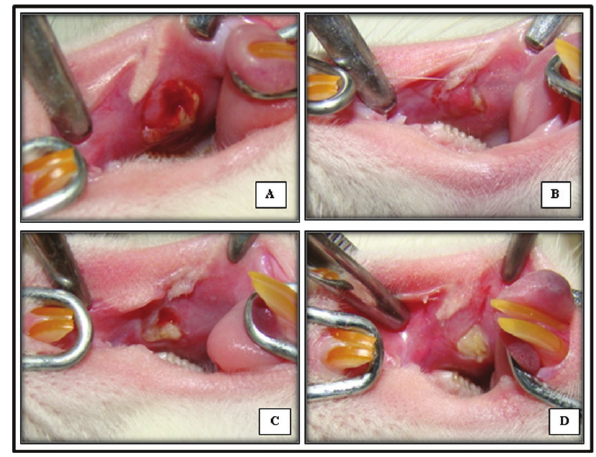
FIGURE 1 - Clinical aspects of the traumatic ulcers in the left cheek mucosa within one ( A ), two ( B ), three ( C ) and four days ( D ) after the induction of the trauma with an nº 15 scalpel